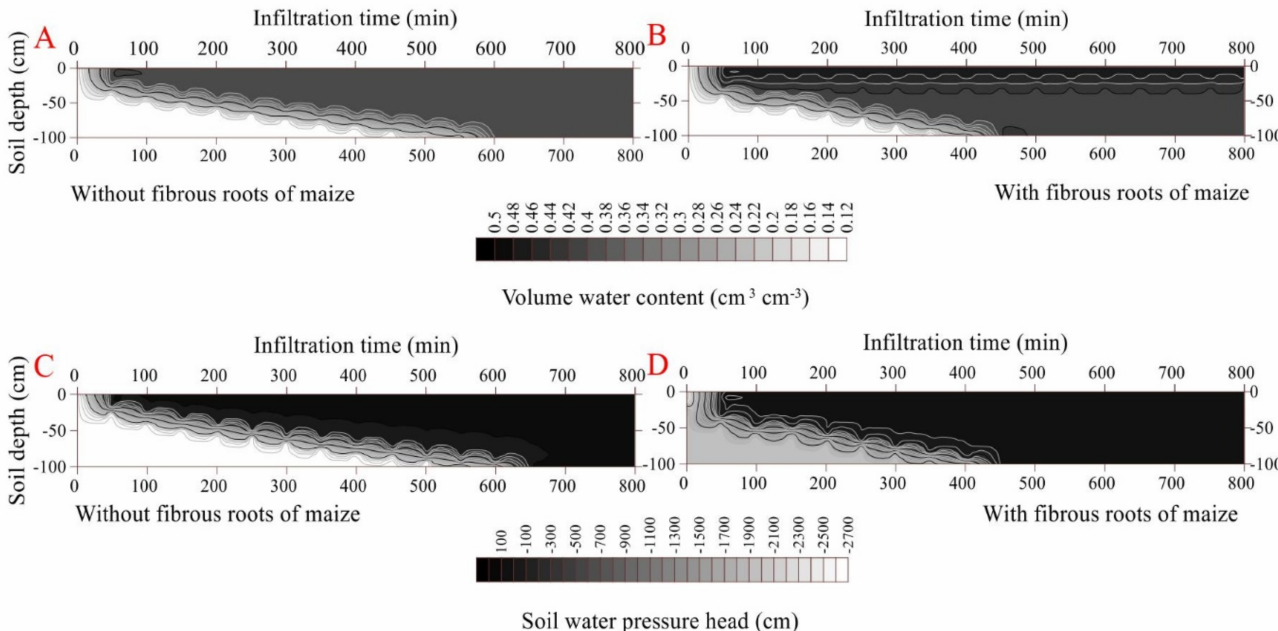
Figure 3. Dynamic characteristics of volumetric water content and soil water pressure head as a func- tion of infiltration time in the soil profile without fibrous maize roots ( A , C ). Dynamic characteristics of volumetric water content and soil water pressure head as a function of infiltration time in the soil profile with fibrous maize roots ( B , D